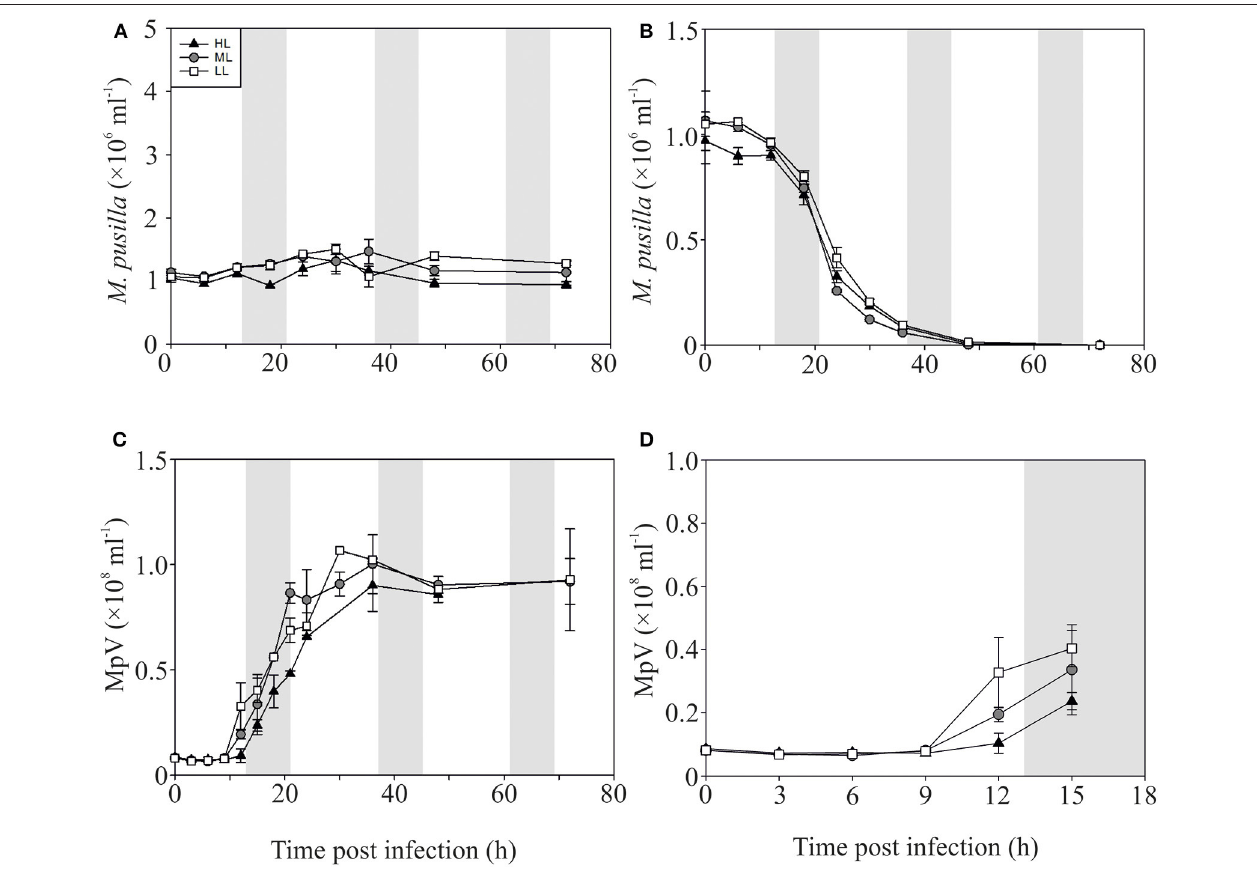
FIGURE 3 | Algal and viral growth curves with abundances of non-infected (A) and infected (B) Micromonas pusilla and MpV (C) under P-limited conditions. (D) Shows MpV abundances in the first 15h in more detail. Light treatments are depicted by triangles (HL), circles (ML), and squares (LL). Values are averages ± s.d. Gray bar depicts dark (night)